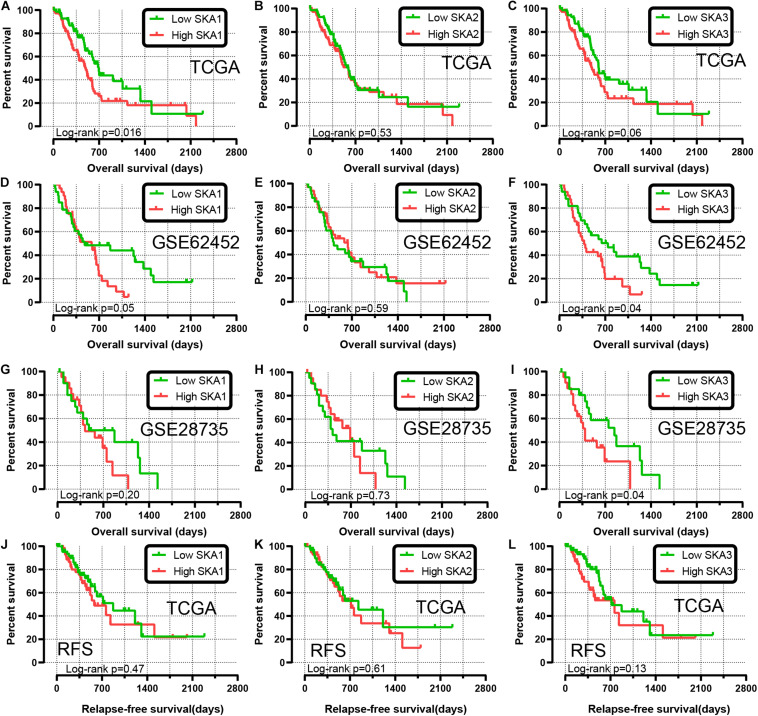
Kaplan-Meier survival curves showing the association of spindle and kinetochore related genes with the overall survival and relapse-free survival of pancreatic ductal adenocarcinoma patients from TCGA and GEO datasets. Overall survival in TCGA: (A)
SKA1; (B)
SKA2; (C)
SKA3; Overall survival in GEO62452: (D)
SKA1; (E)
SKA2; (F)
SKA3; Overall survival in GEO28735: (G)
SKA1; (H)
SKA2; (I)
SKA3; Relapse-free survival in TCGA stratified by (J)
SKA1; (K)
SKA2; (L)
SKA3.